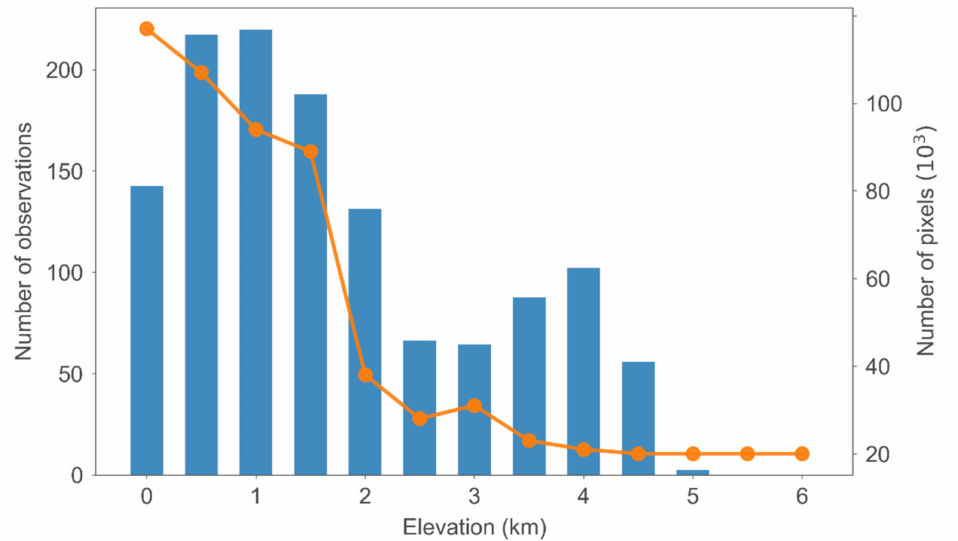
Figure 2. Number of observations and pixels in each elevation bin in Southwest China. The blue histogram denotes the number of observations, and the orange line denotes the number of